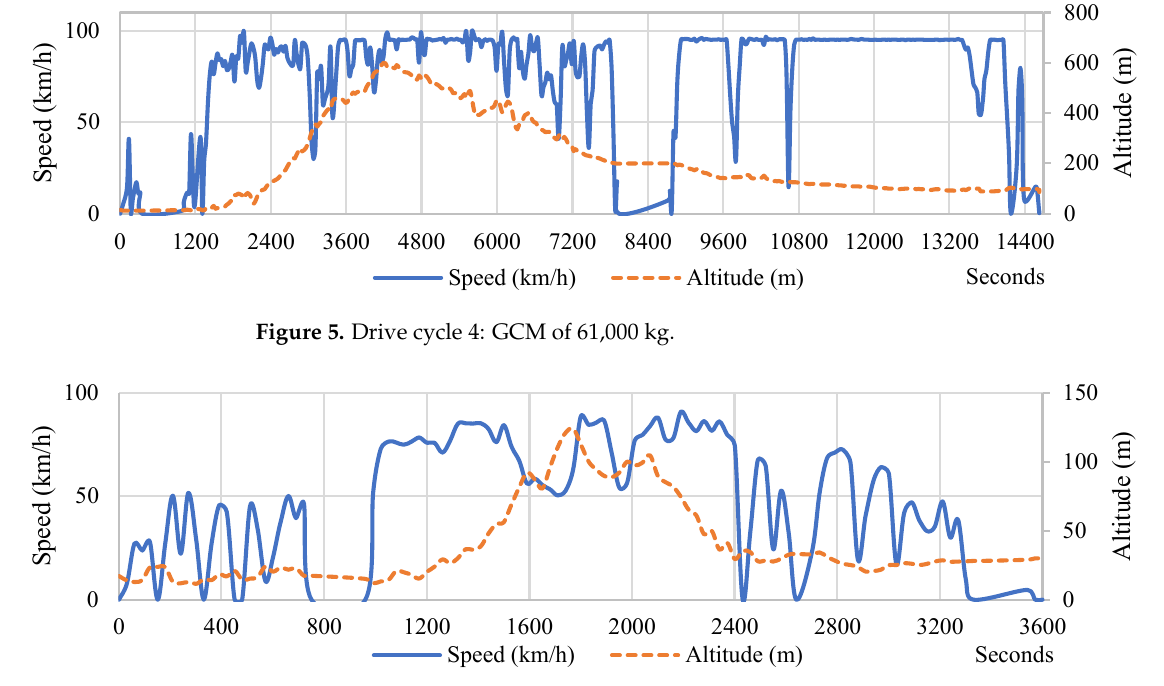
Figure 6. Drive cycle 5: GCM of 66,000 kg. Table 1. Drive cycle summary.